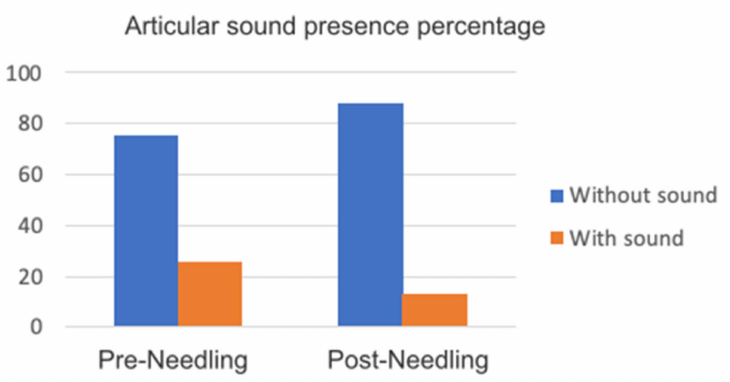
Figure 10. Graph articular sound presence